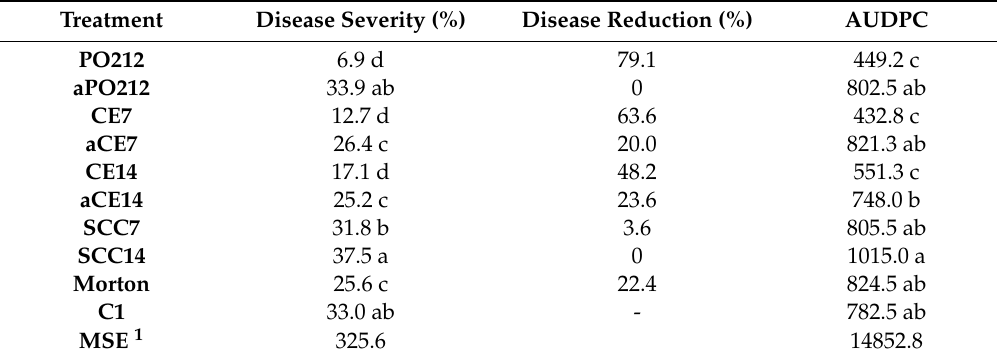
Table 2. Activity of Penicillium rubens strain 212 (PO212) crude extracts (CE) and conidia (SCC) against disease caused by strain 1A of Fusarium oxysporum f.sp. lycopersici (FOL1A) in tomato plants at 28 days after transplanting and inoculation in growth chamber assays.